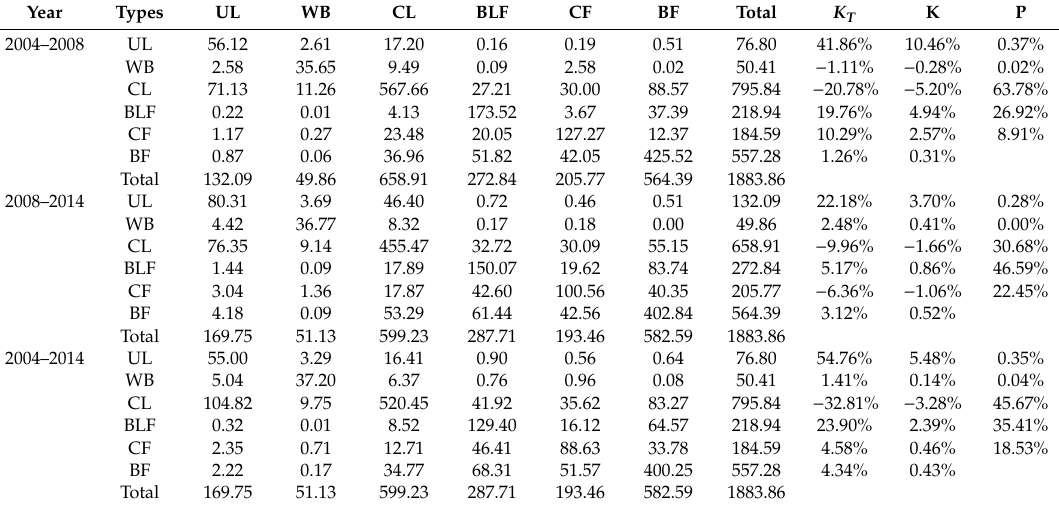
Table 5. The transition area matrix (km 2 ) and contribution rate in di ff erent periods of 2004–2014 in Anji